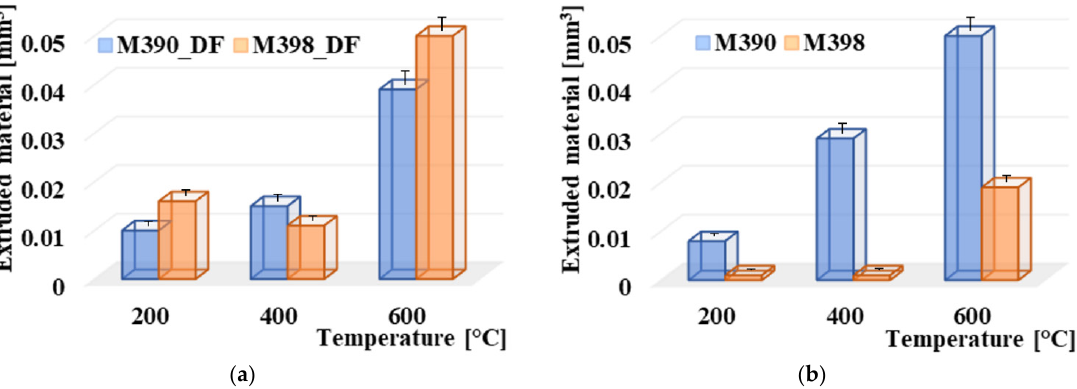
Figure 10. Comparison of plastic deformation results: ( a ) M390_DF and M398_DF and ( b ) M390 and M398.